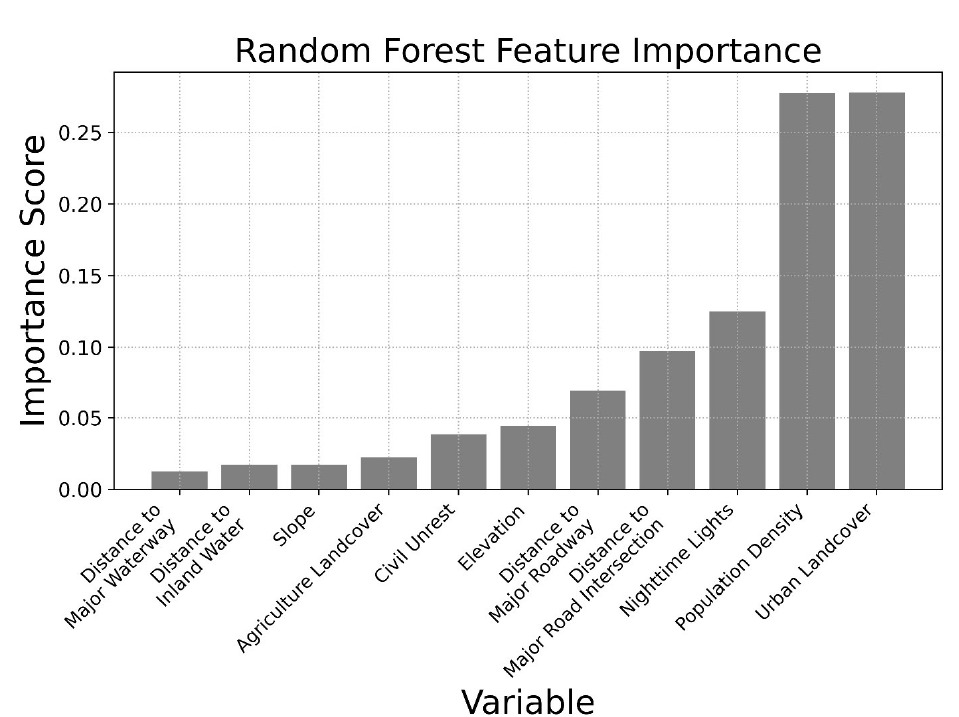
Figure 4. Random Forest feature importance scores. Urban landcover classification, population den- sity, and nighttime lights are the most important features impacting model prediction. These find- ings are in line with previous qualitative studies and enhance our understanding of terrorist target